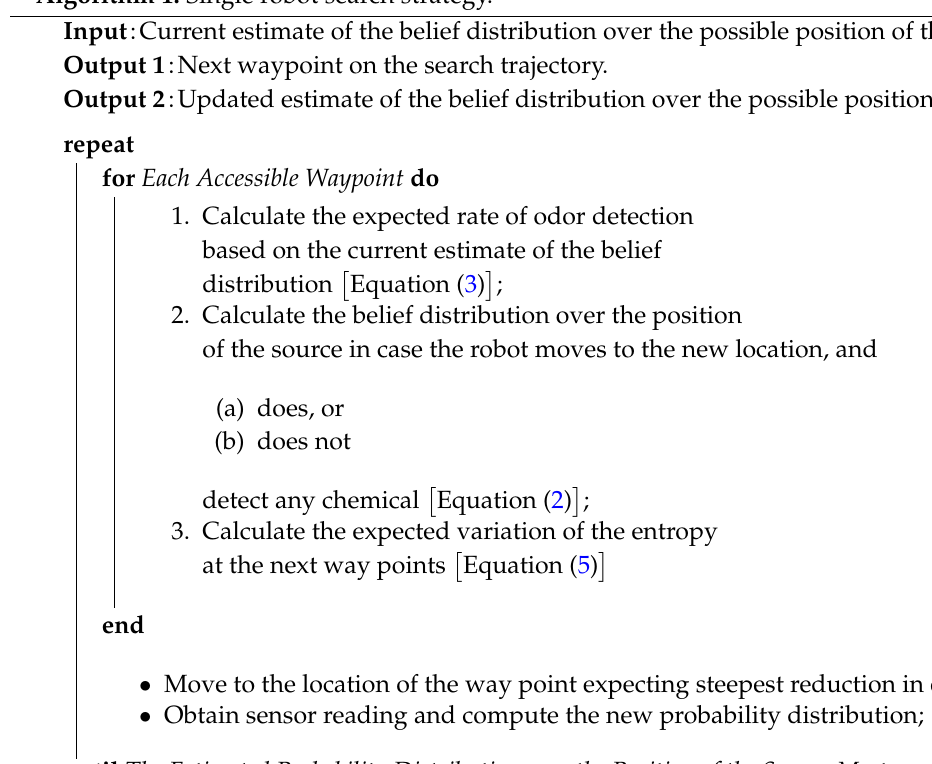
Algorithm 1: Single robot search